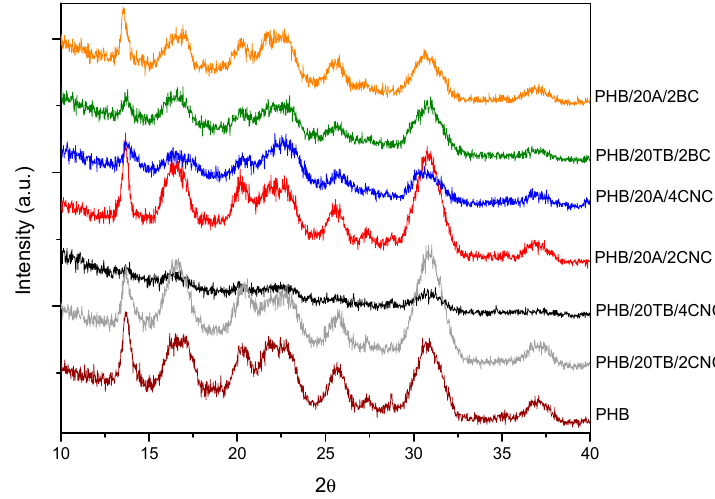
Figure 13. XRD spectra of PHB and plasticized nanocomposites with 14 days under compost conditions.